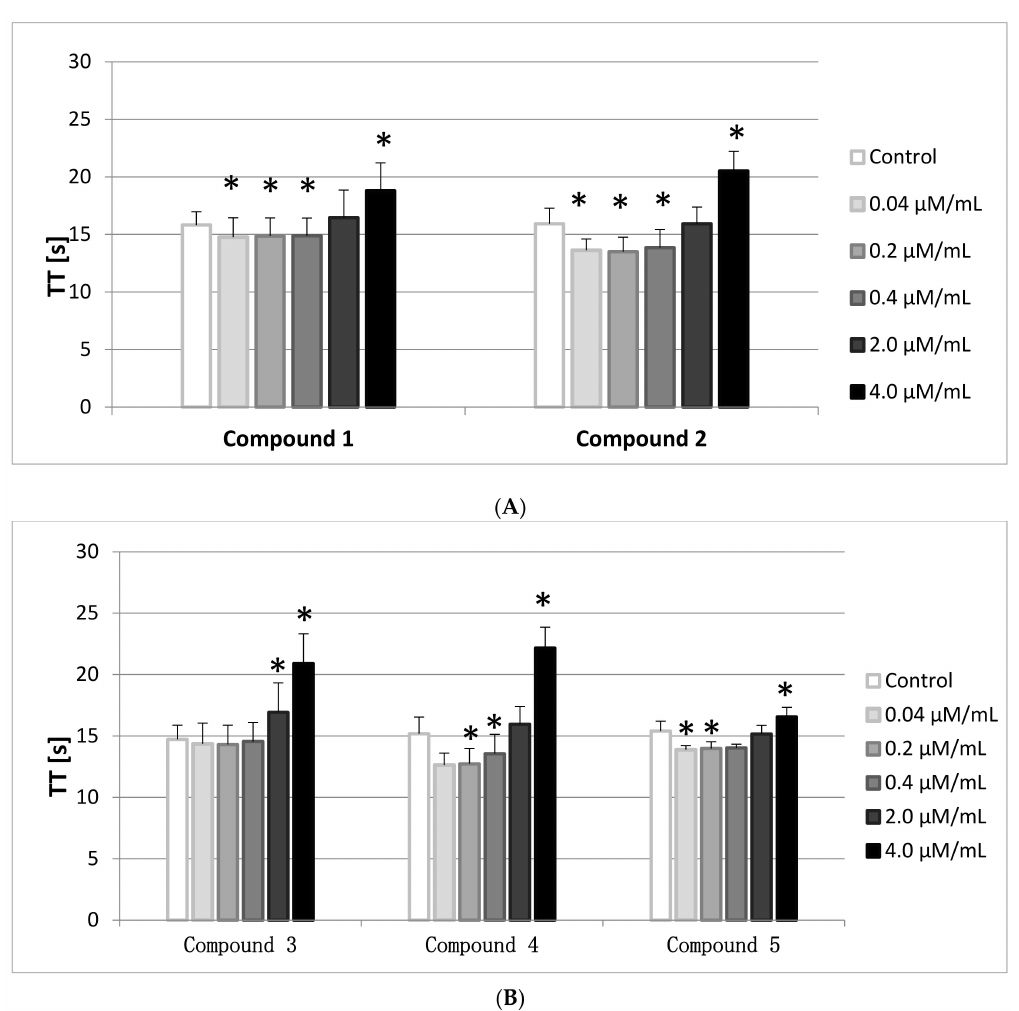
Figure 6. The effects of iminodiacetic acid derivatives ( A ) compounds 1 and 2 ; ( B ) compounds 3 – 5 on Thrombin Time (TT) (mean ± SD; n = 4–5) after 2 min incubation in plasma; final volume 210 µ L. All synthesized compounds apart from 3 at the lowest concentration range (0.04–0.2/0.4 µ